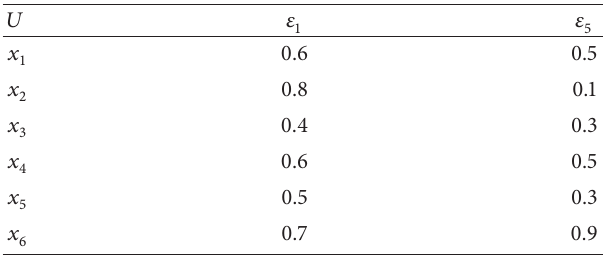
Table 6: Tabular representation of (𝑀,𝑁)